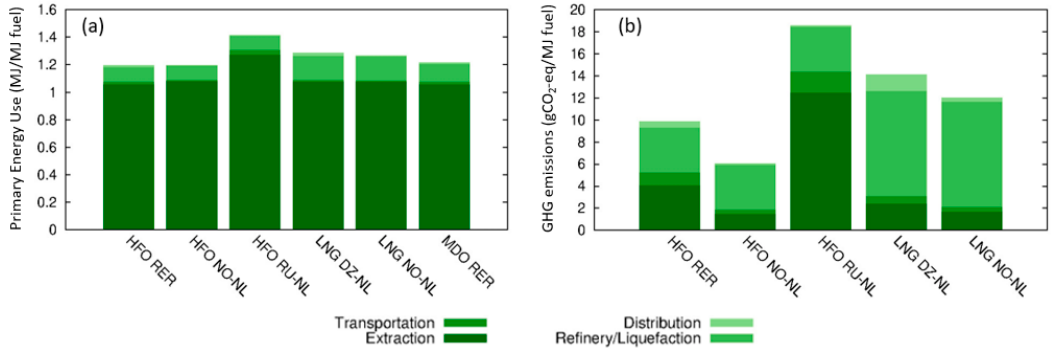
Figure 5. Contribution of modelled fuel supply chain processes to cradle-to-tank: ( a ) Primary Energy Use; ( b ) GHG emissions.